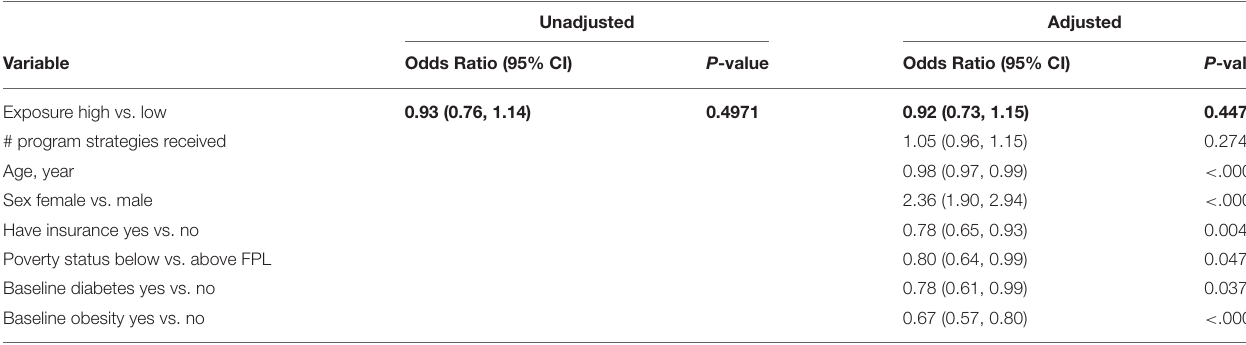
TABLE 3 | TSSC program effect on changing from HTN/Elevated Stage to Normal BP stage based on logistic regression analysis ( n = 3,519).